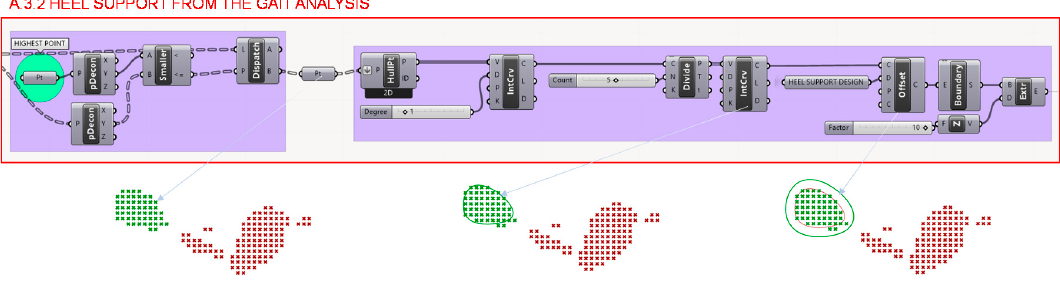
Figure 15. Programming structure definition developed to determine the support of the heel from the gait analysis.